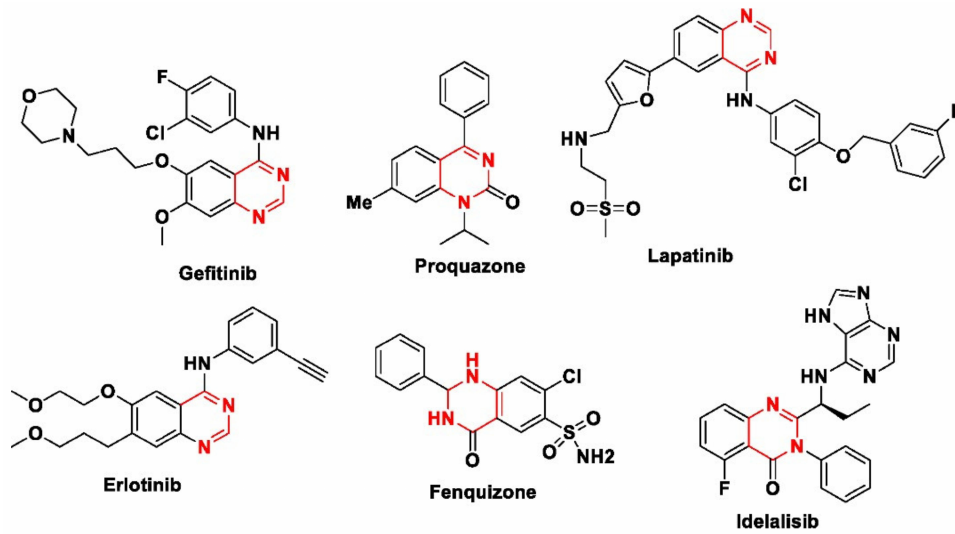
Figure 1. Biologically active quinazoline